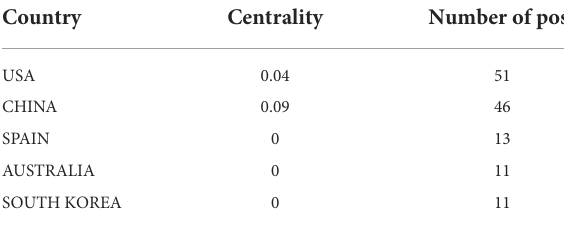
TABLE 2 Country distribution and number of documents